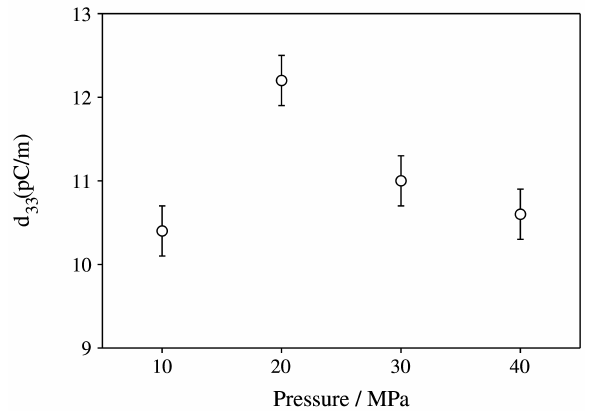
Figure 4. d 33 coefficient as a function of applied pressure. Composite PZT/PU/C with 59/40/1 vol. % poled for 10